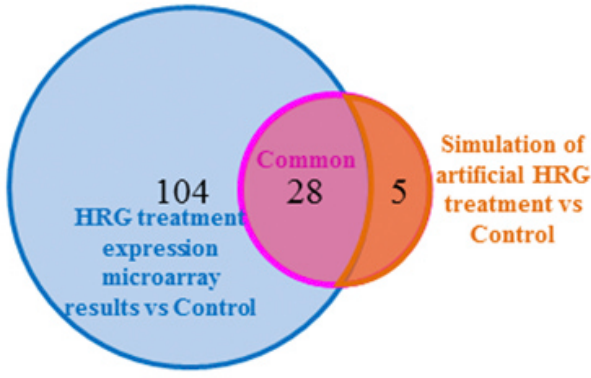
Figure 4. Venn diagram comparing simulation of HRG expression microarray results with simulation of artificial HRG treatment prediction. 28 genes were common to both analyses (pink). 5 genes were unique to simulation (orange), and 104 genes were unique to experimental analysis (blue).